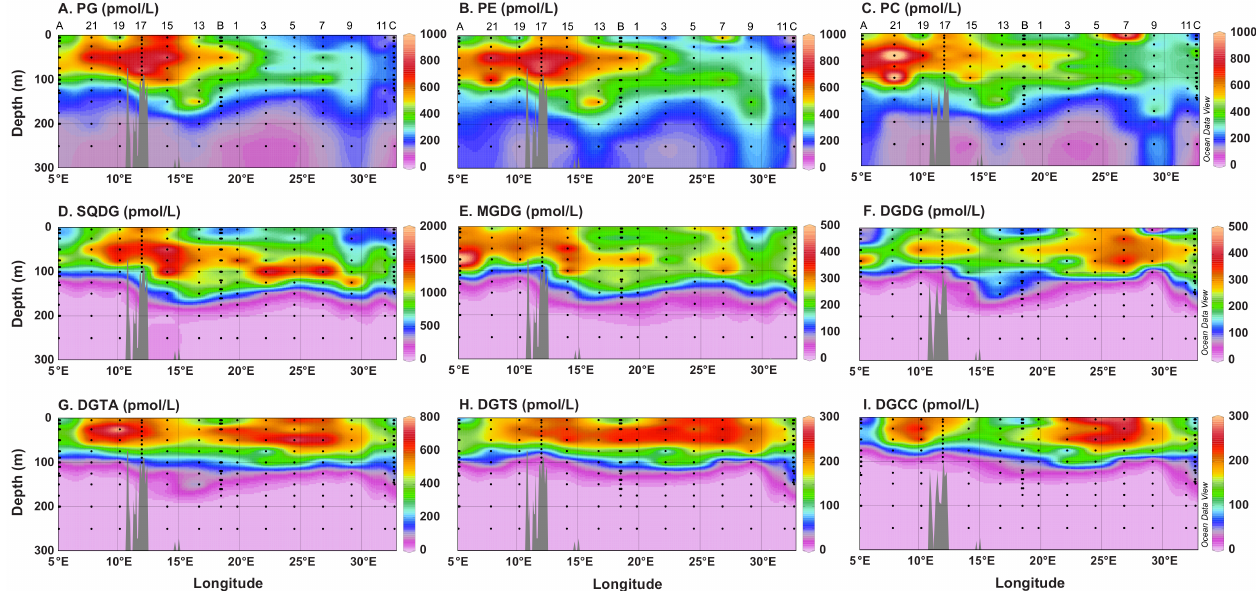
Fig. 3. Distribution of the nine most abundant IP-DAGs in the upper water column (300m), each panel showing the concentration of a single class of IP-DAG from west to east across the Mediterranean Sea. The first row (A–C) is phospholipids; the second row (D–F) is glycolipids; the third row (G–I) is betaine lipids. Numbers across the top panels indicate station labels; black dots indicate individual samples, colored contours indicate interpolated